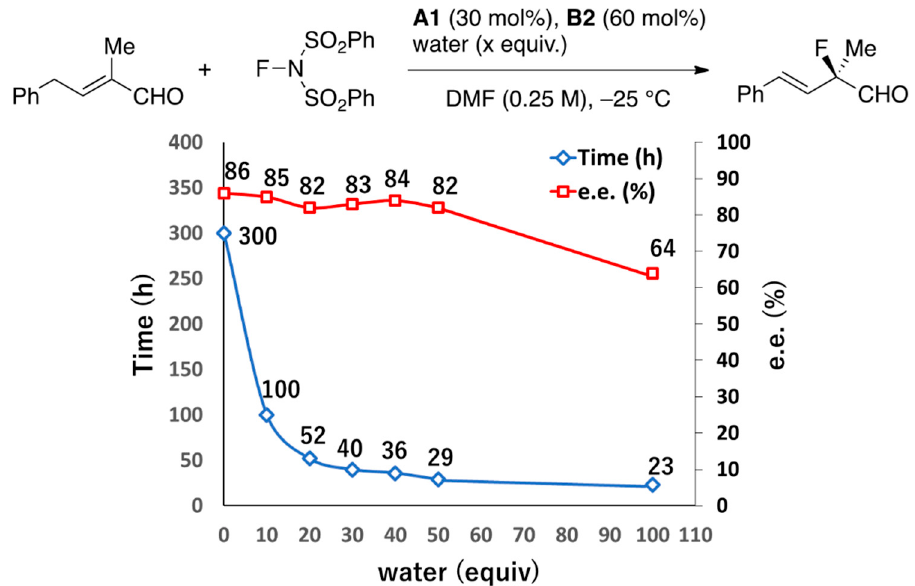
Figure 1. Experimental results of water addition.